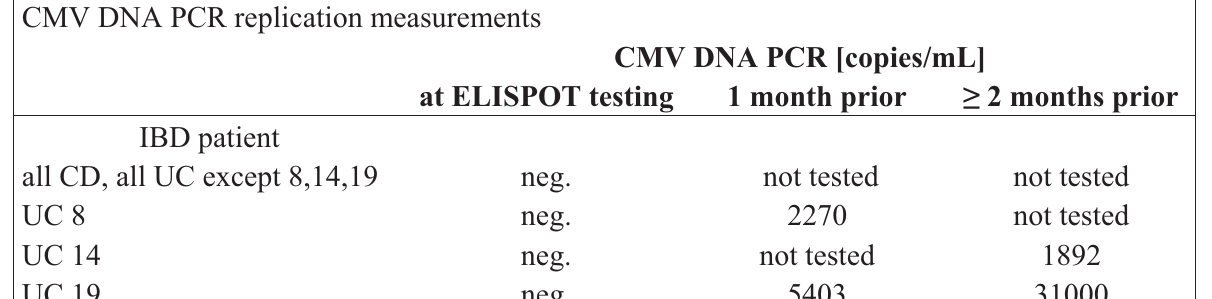
Table 1. Detection of CMV viral replication measured by PCR. When blood was obtained from IBD patients (ulcerative colitis (UC) or Crohn’s disease (CD)) for PBMC isolation for ELISPOT CMV-reactivity analysis, CMV DNA was also measured by PCR in blood samples.